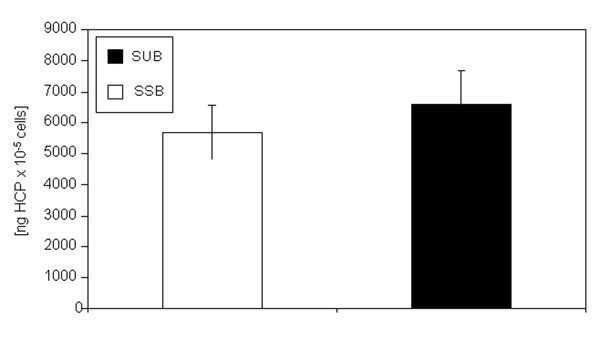
HCP concentration